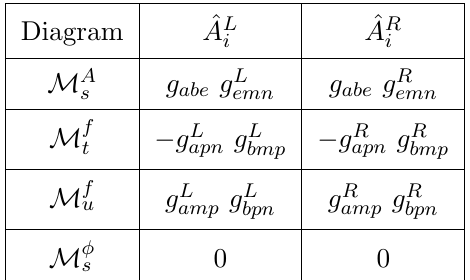
Table 2 . Coe(cid:14)cients ^ A L